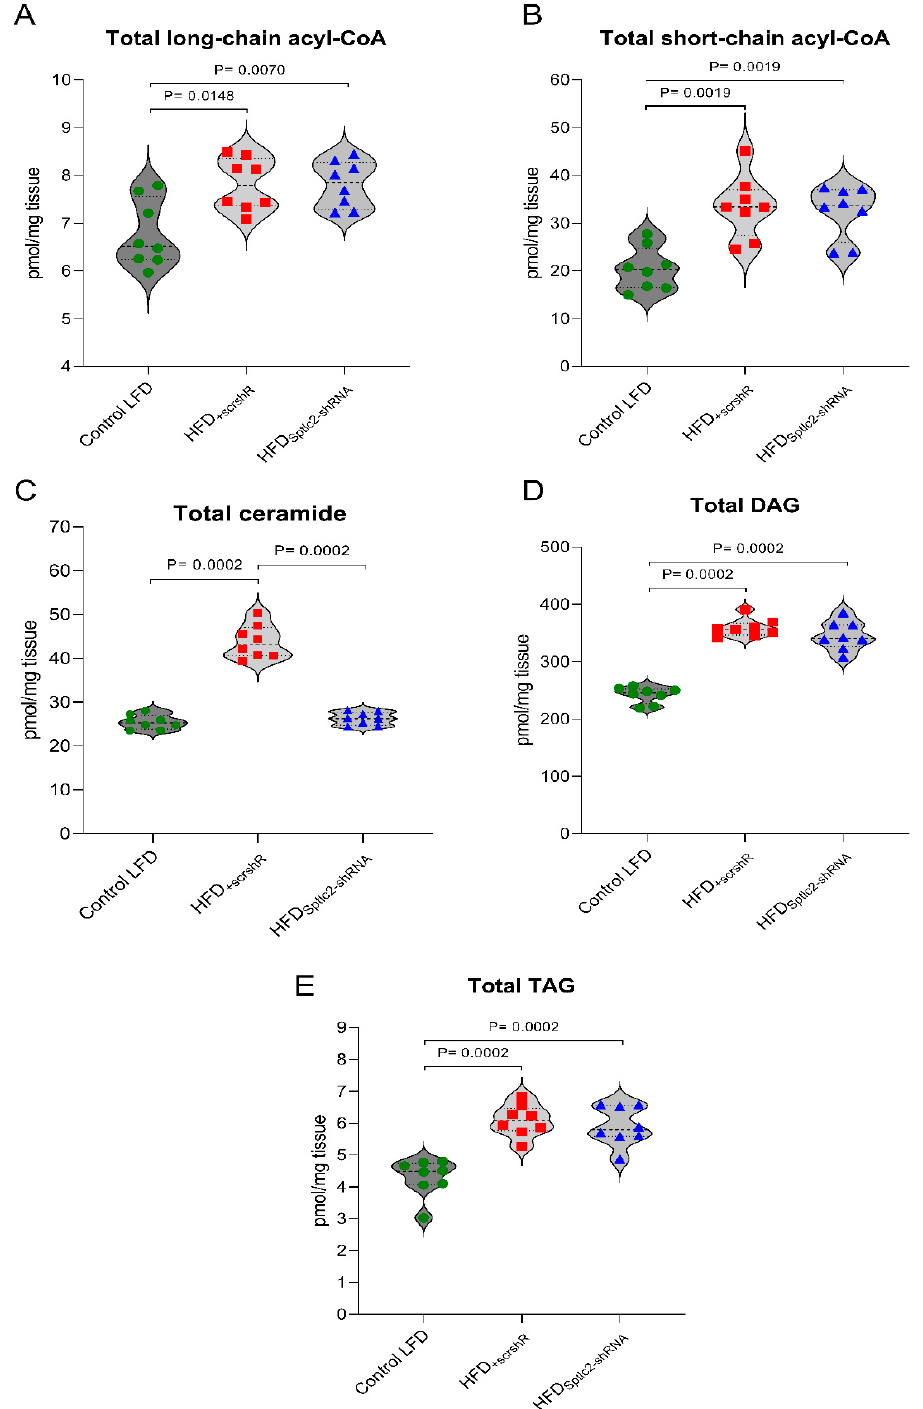
Figure 4. ( A – E ) The impact of skeletal muscle Sptlc2 silencing on the content of bioactive lipids: ( A ) the content of long-chain acyl-CoA; ( B ) the content of short-chain acyl-CoA; ( C ) the content of ceramide; ( D ) the content of diacylglycerols; ( E ) the content of triacylglycerol. Significance by Mann–Whitney U test. The figures show the median and interquartile range ( n = 8). Green circles—values for individual Control LTD gastrocnemius muscles; Red squares—values for indi- vidual HFD +scrshRNA gastrocnemius muscles; Blue triangles—values for individual HFD Sptlc2-shRNA gastrocnemius